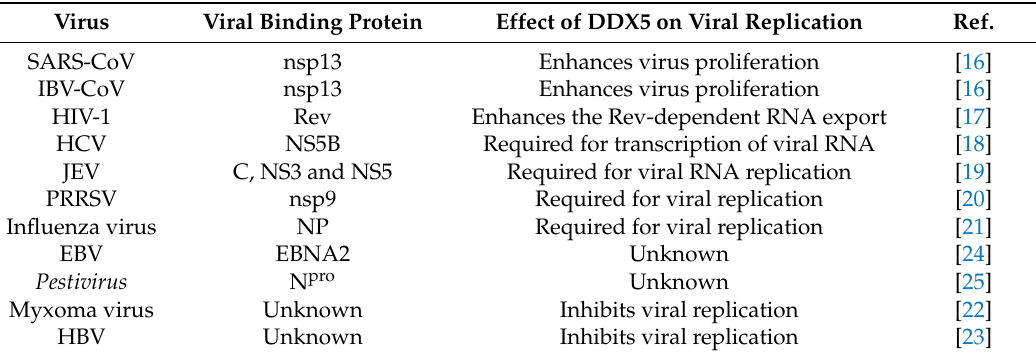
Table 1. Overview of the role of DEAD box polypeptide 5 (DDX5) in virus infection.